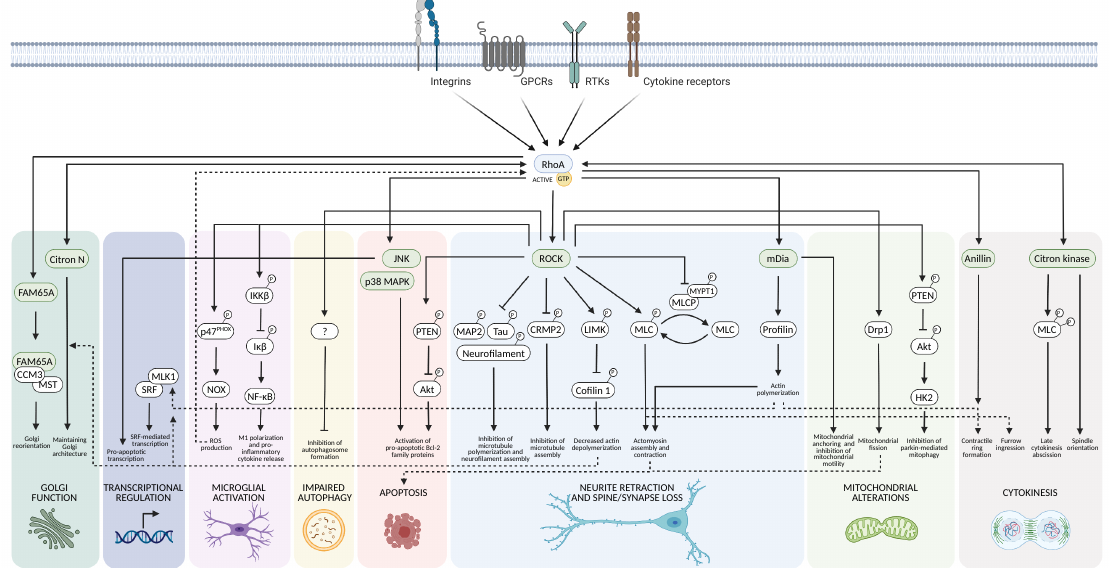
Figure 3. RhoA signaling. RhoA transmits signals from a variety of different cell surface receptors, such as integrins, tyrosine kinase receptors, G protein-coupled receptors, and cytokine receptors, by interacting with downstream effector molecules involved in many cellular processes. These include, Golgi function, gene transcription, inflammation, autophagy, cell death, cytoskeletal modulation, mitochondrial homeostasis, and